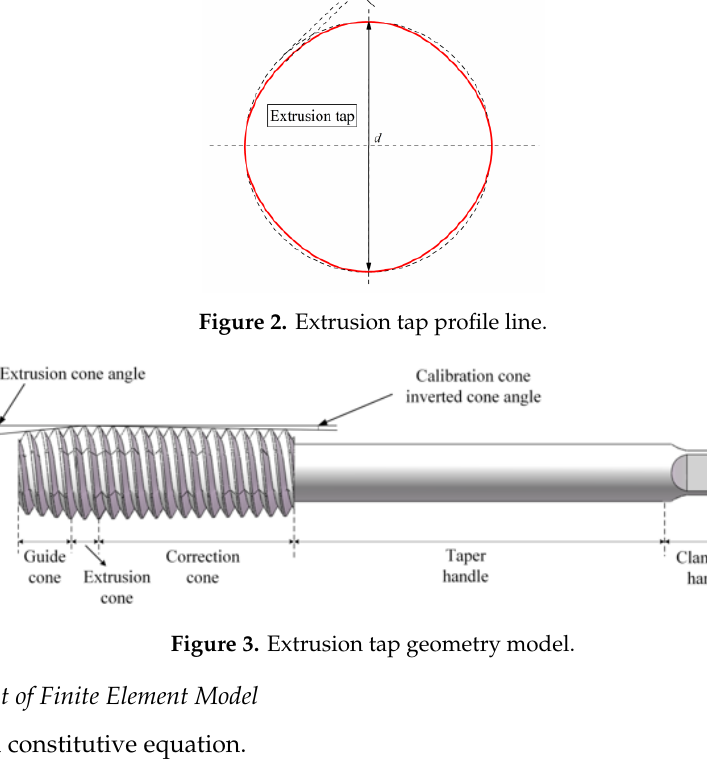
Figure 3. Extrusion tap geometry model.